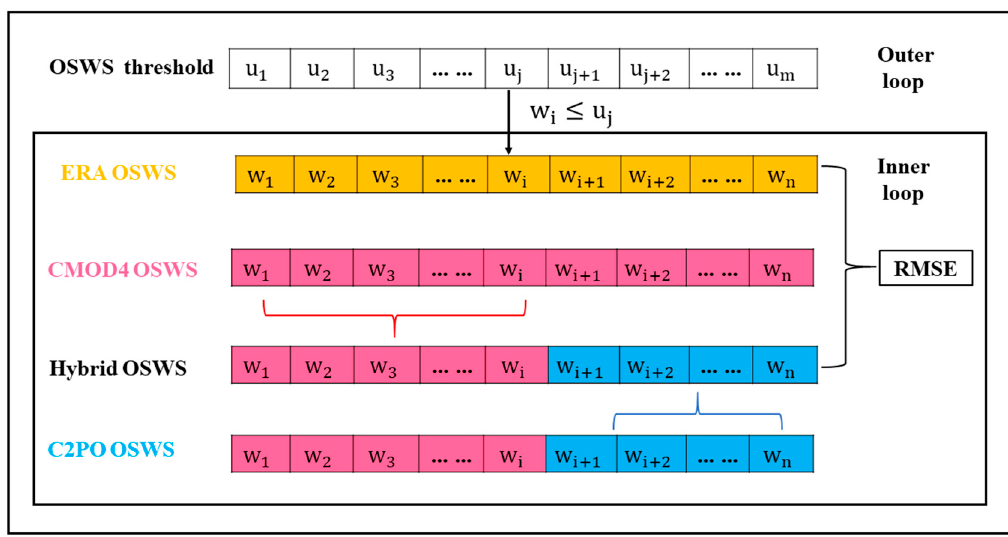
Figure 8. Design of a double loop program to find the best OSWS threshold value based on the training data.